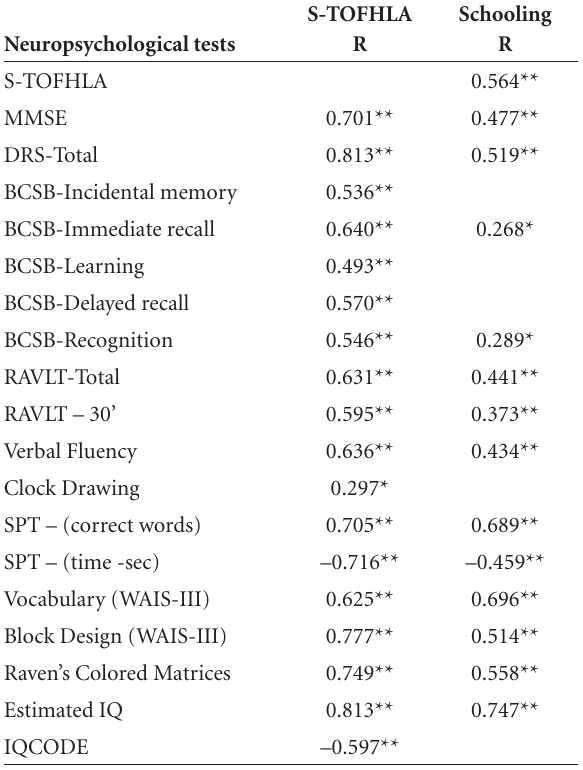
Table 3. Spearman’s correlations among S-TOFHLA scores, schooling, and neuropsychological tests. Neuropsychological